Question: Give a one-sentence summary of this figure.
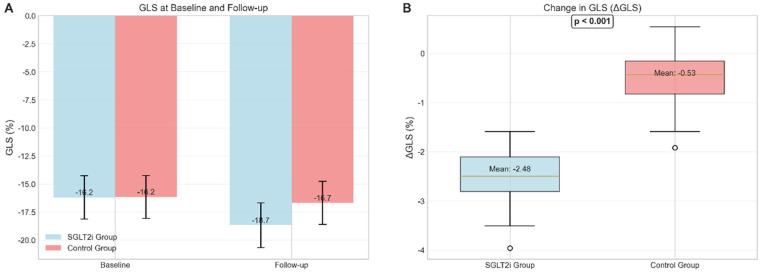
Answer: Changes in global longitudinal strain (GLS) from baseline to follow-up. (A) Bar graph comparing GLS at baseline and follow-up between the SGLT2i and control groups. Data are shown as mean ± SD. (B) Box-plot showing the change in GLS ( Δ GLS) from baseline to follow-up. The central line indicates the median, boxes represent the interquartile range, and whiskers denote the range. The p -value was derived from an independent t-test.